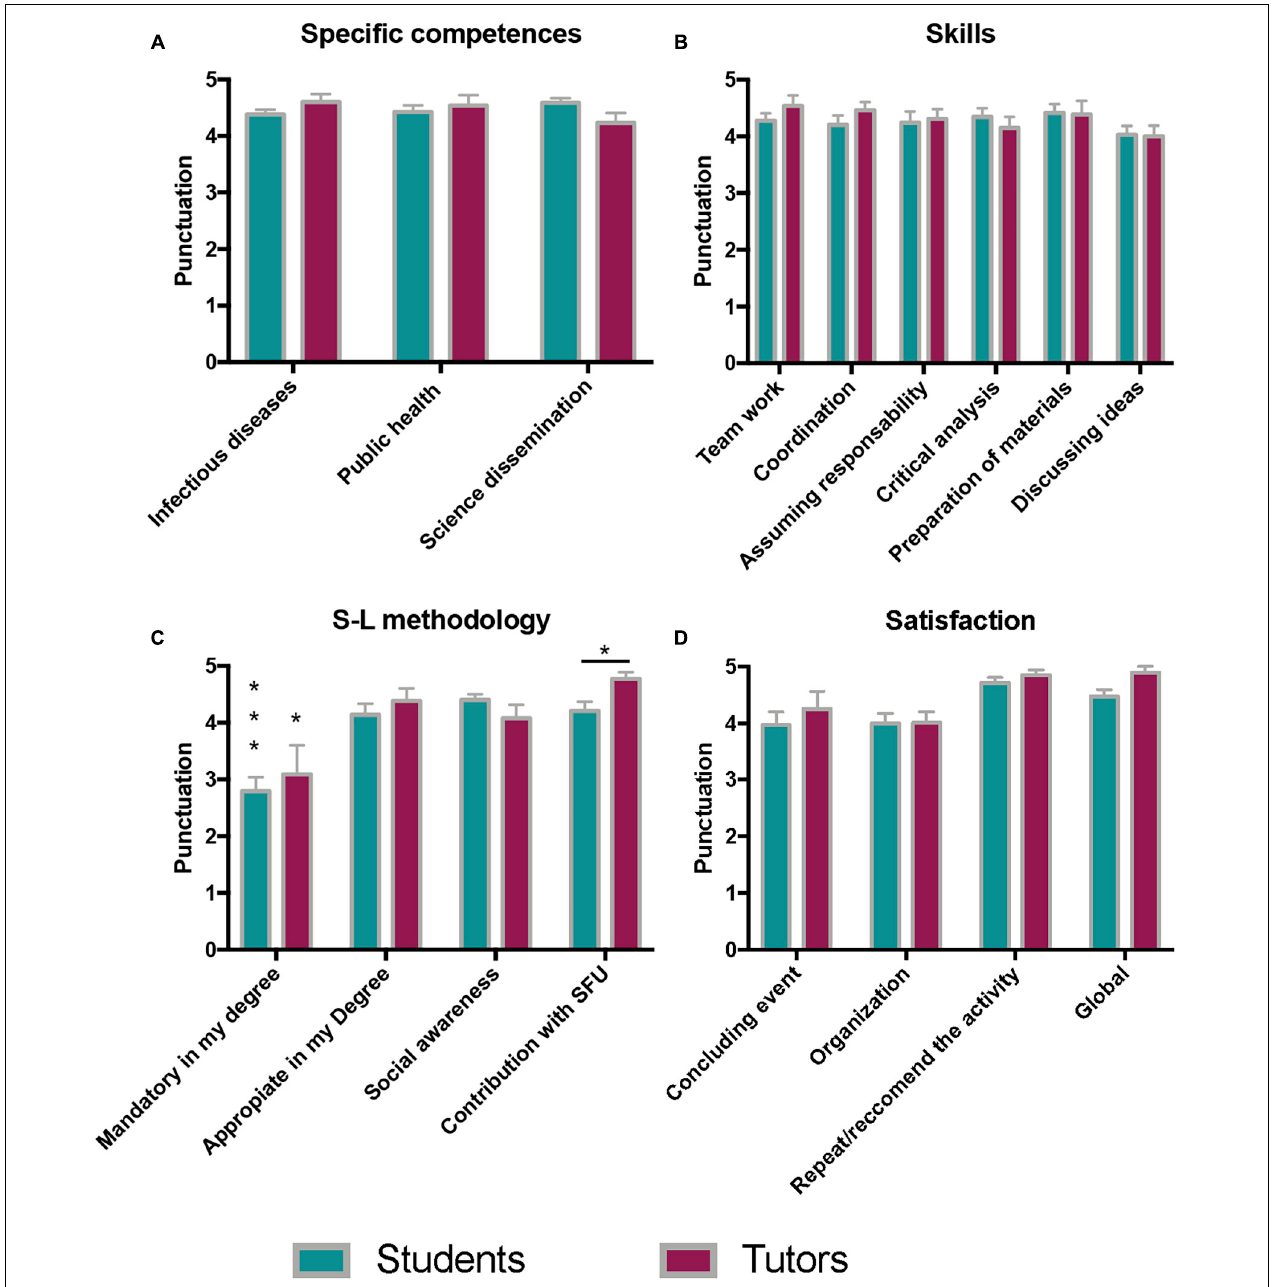
FIGURE 2 | Selected survey results from undergraduate students ( n = 29) and tutors ( n = 13) involved in Movies and Infectious Diseases S-L project at Universidad Complutense de Madrid, Spain, after 2 years of experience. (A) Scientific competencies and learning. (B) General skills acquired during the activities. (C) Adequacy and utility of the S-L methodology, (D) Satisfaction with the experience and activities. All data are expressed as mean and standard deviation on a 1–5 scale (1, very low/strongly disagree; 5, very high/strongly agree). Significant differences between the marked groups and the remaining groups are highlighted with asterisks (* p < 0.05; *** p <